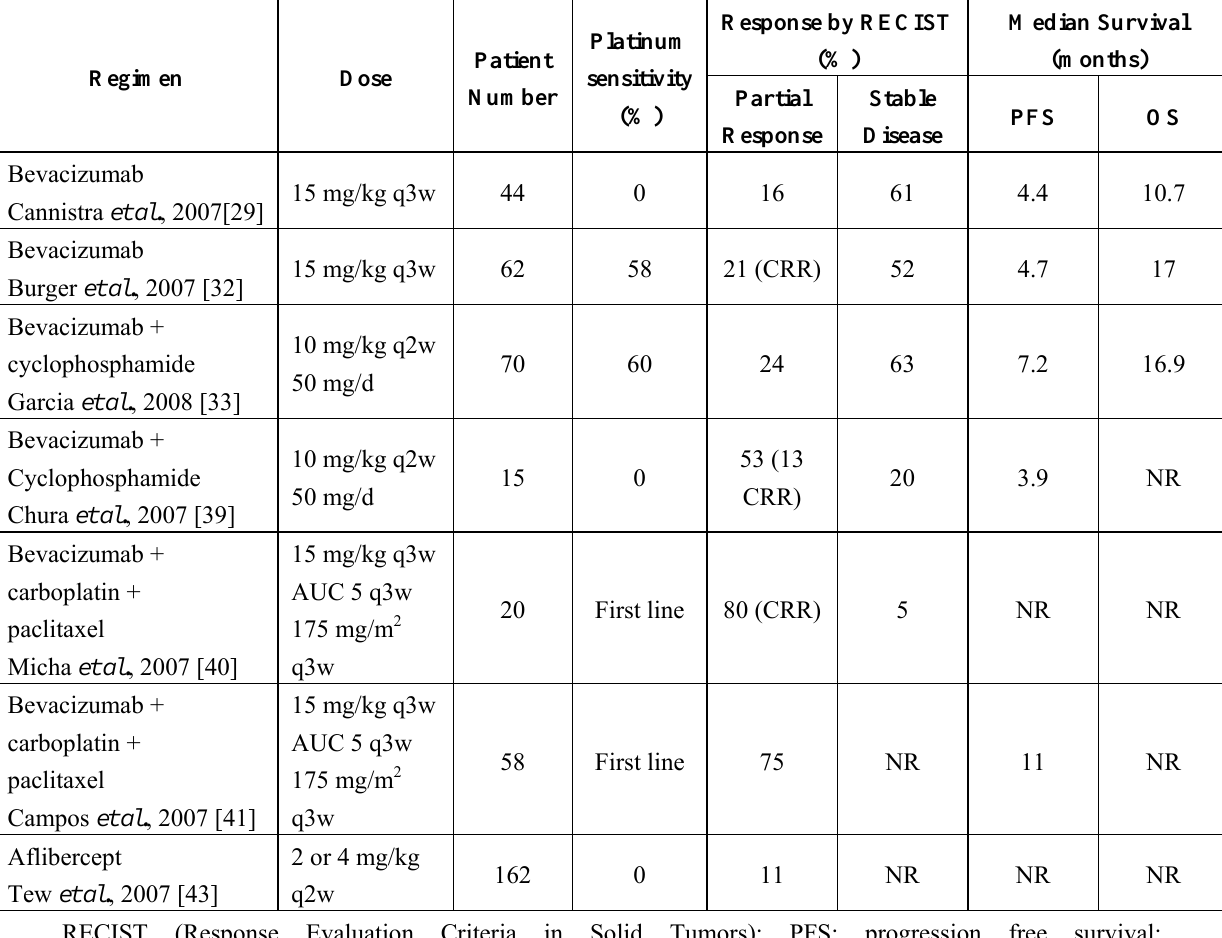
Table 1. Phase II trials of antiangiogenic agents in ovarian